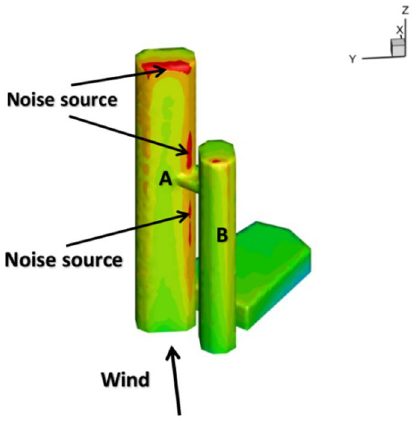
Figure 6. Noise source localization.